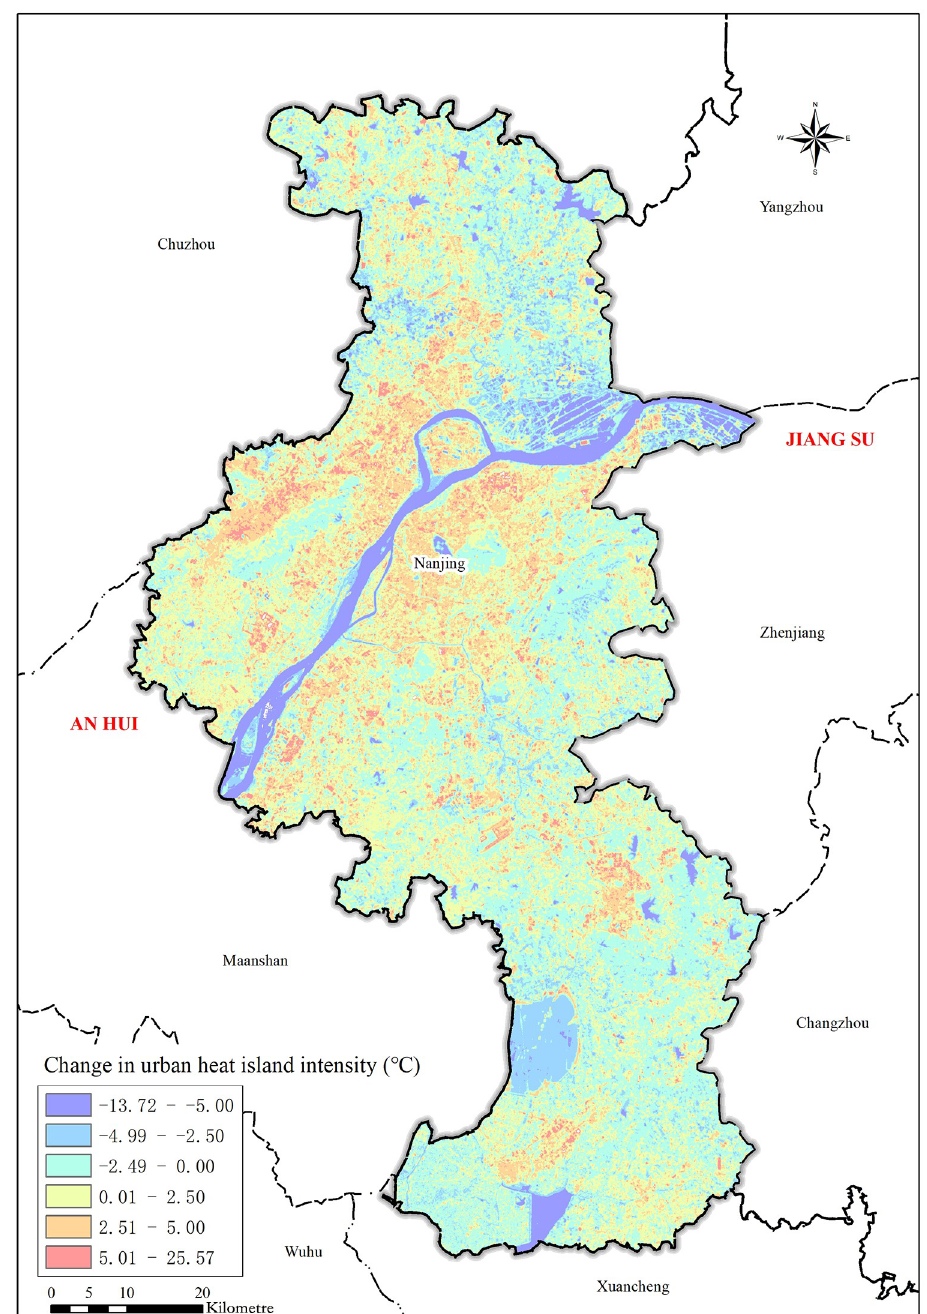
Fig 4. A spatial and temporal variation map of heat island intensity in Nanjing city from 2014 to